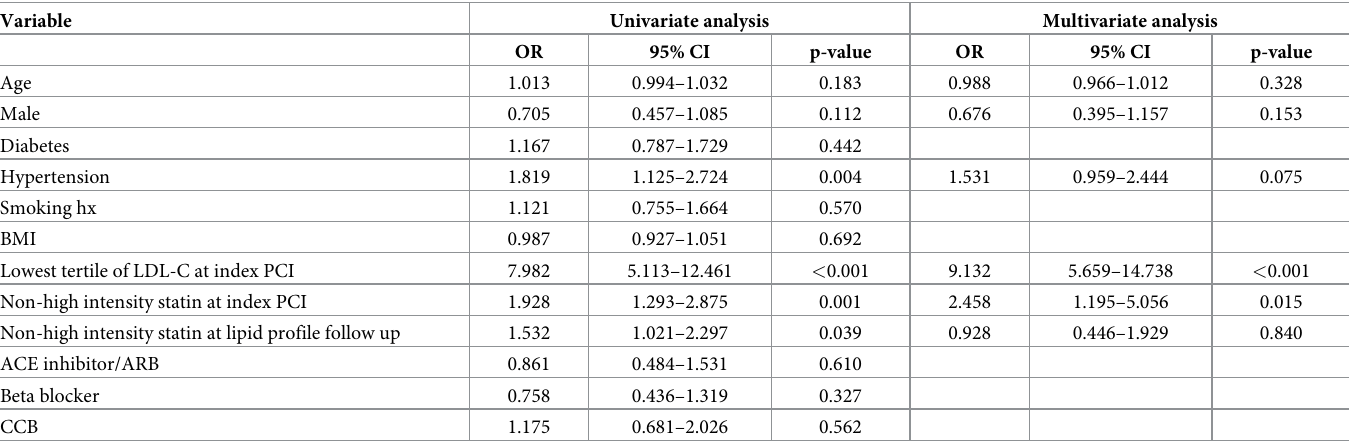
Table 4. Independent predictors for lowest tertile of Apo B/A1 ratio